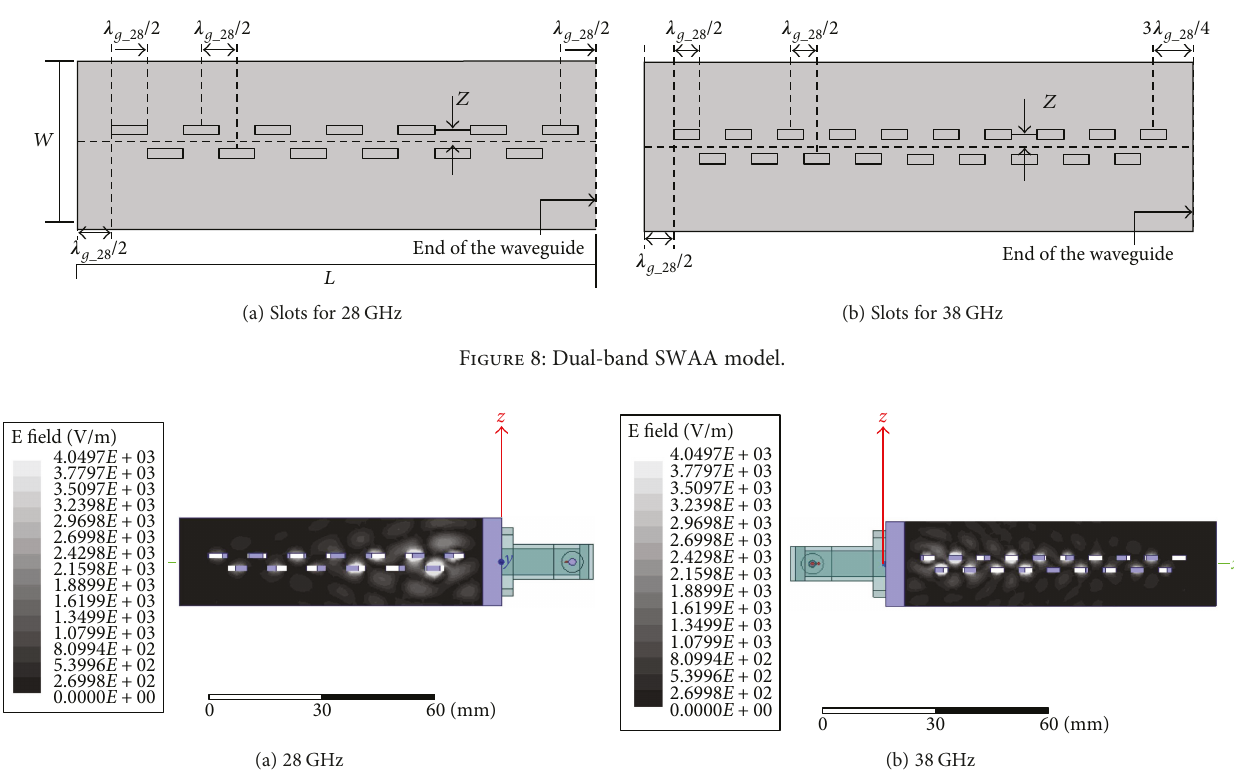
Figure 9: Electric fi eld distribution on the